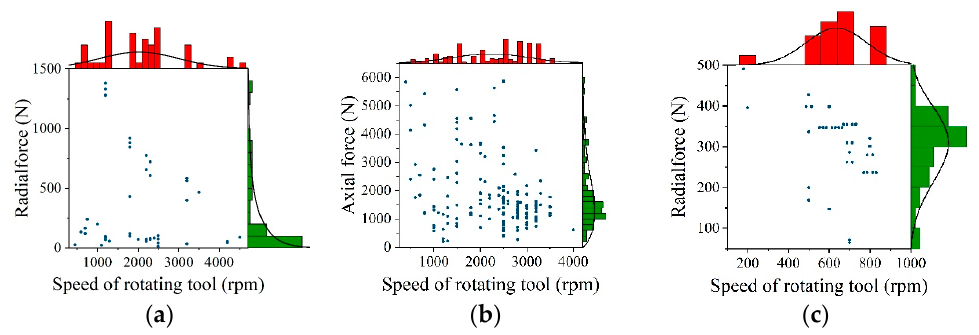
Figure 18. Distribution of key working conditions in different operations. ( a ) Distribution of milling. ( b ) Distribution of drilling. ( c ) Distribution of boring.